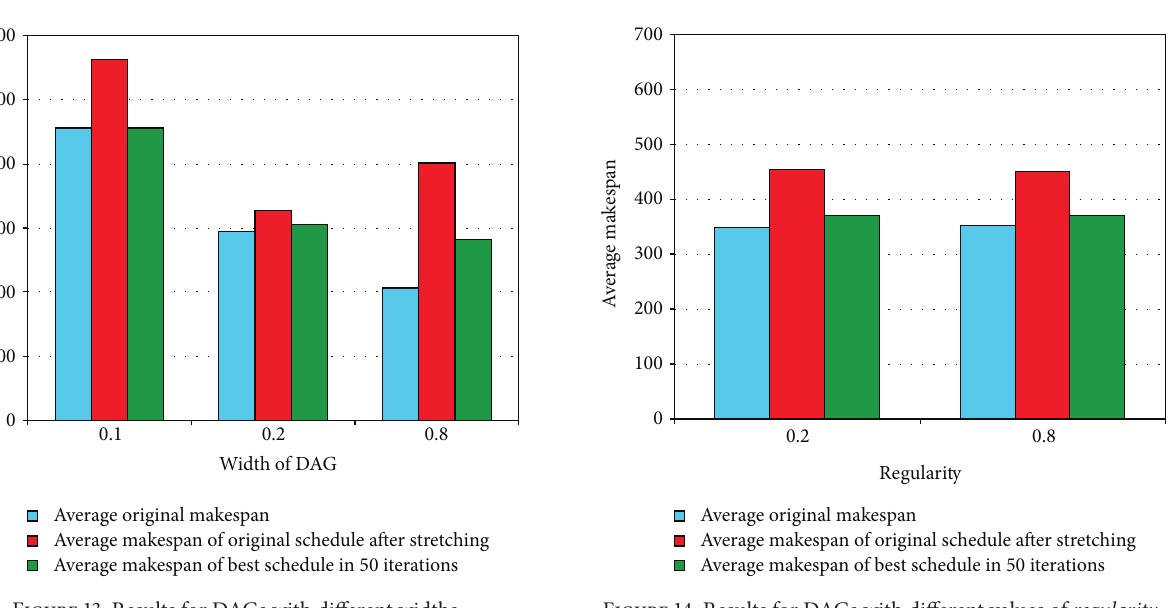
Figure 14: Results for DAGs with different values of regularity . Table 6: Performance for DAGs with different regularity values.